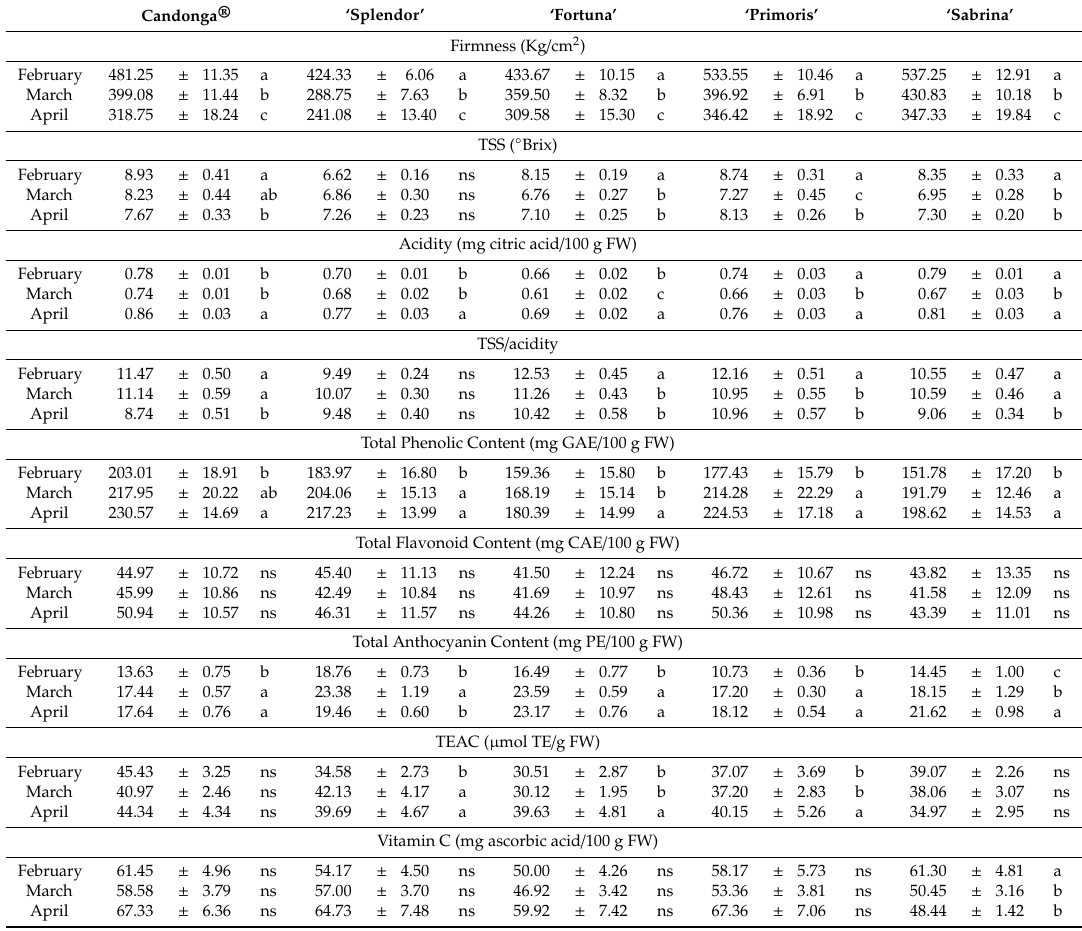
Table 3. Intra-annual variation of the organoleptic and functional fruit quality parameters in the five strawberry varieties. Each value is the mean ± SE for each harvest time regardless of the year. On each variety, letters indicate significant di ff erences ( p < 0.05) between harvest times. Candonga ® ‘Splendor’ ‘Fortuna’ ‘Primoris’ ‘Sabrina’ Firmness (Kg / cm 2